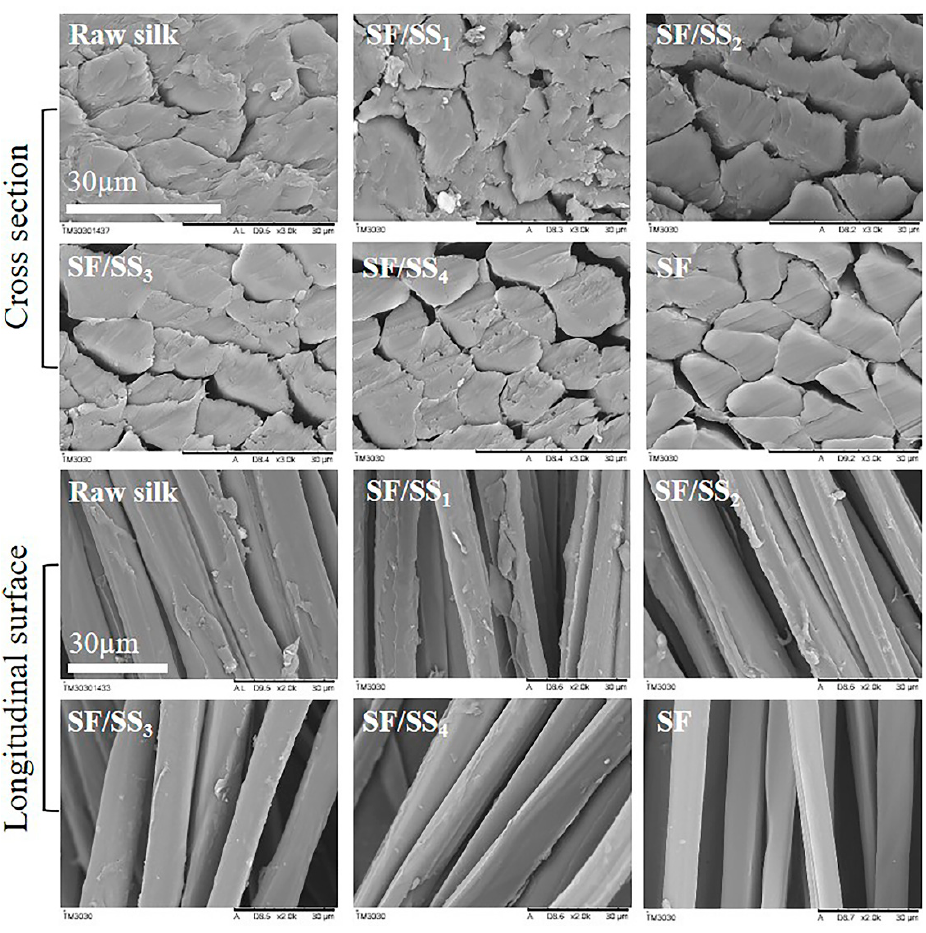
Figure 1. The microstructure of silk in different degumming degrees.